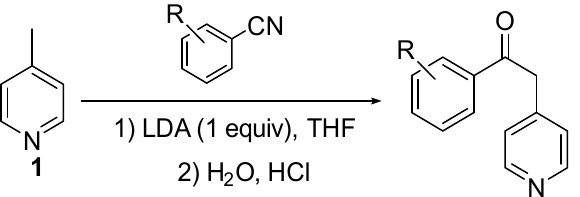
Figure 1. Synthesis of aryl pyridylmethyl ketone via addition to nitriles [4–7].